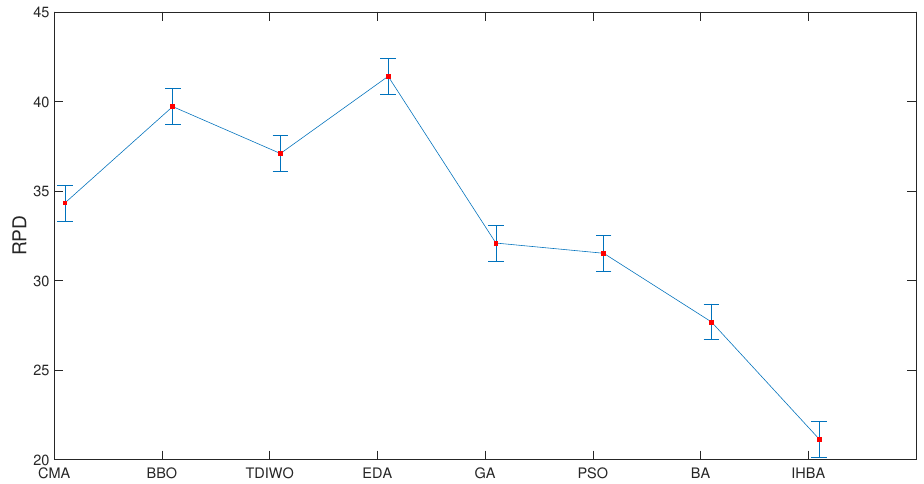
Figure 1. Mean plot and 95% LSD interval of the bat algorithm at C =